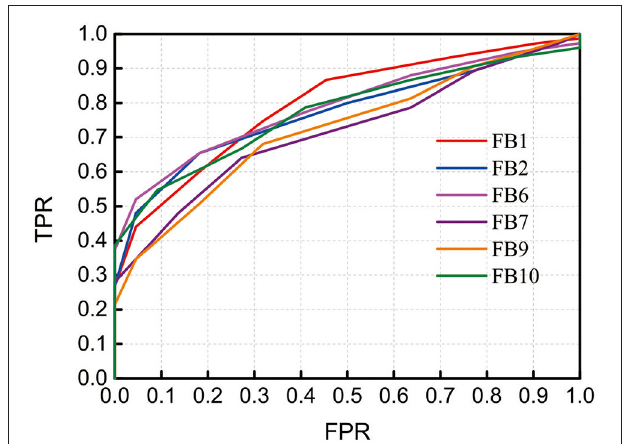
FIGURE 4 | Receiver operating characteristic (ROC) curves obtained by using RSFC as discriminative features at several frequency bands in which RSFC is significantly different between the ASD and TD groups. The RSFC in each band is the mean of RSFC averaged over all channel pairs. AUC (FB1) =